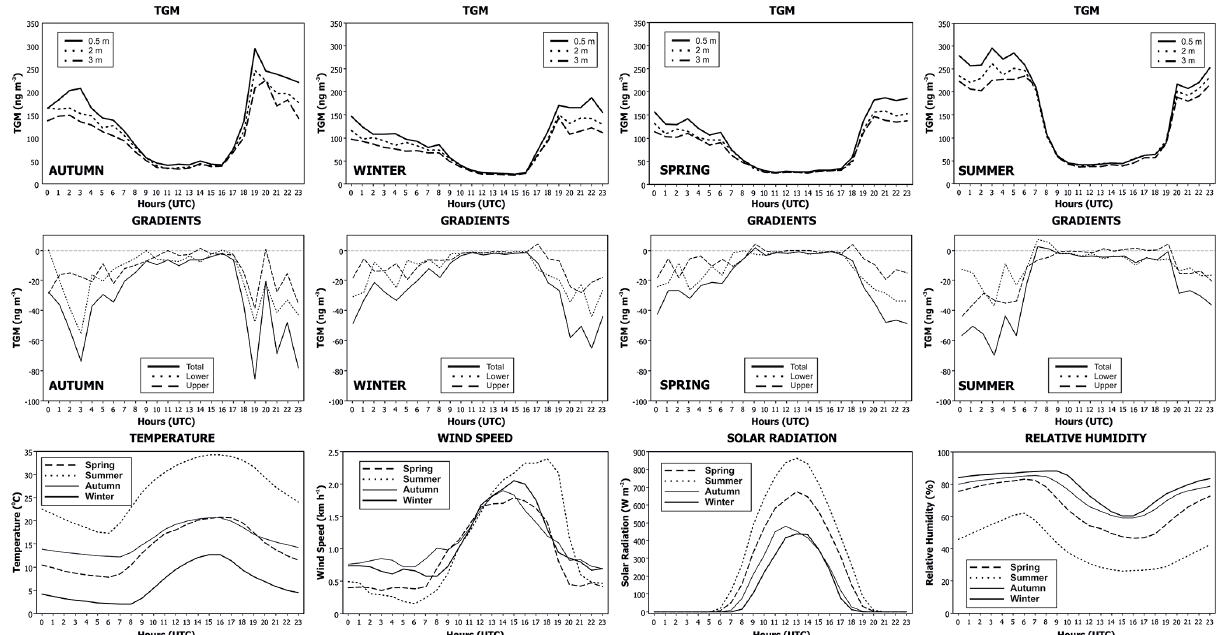
Figure 2. Daily and seasonal evolution of TGM contents at 3, 2 and 0.5m above the ground at the AWTP site (upper row); daily and seasonal evolution of gradients at 3–0.5, 3–2 and 2–0.5m above the ground at the AWTP site (middle row); and daily and seasonal evolution of